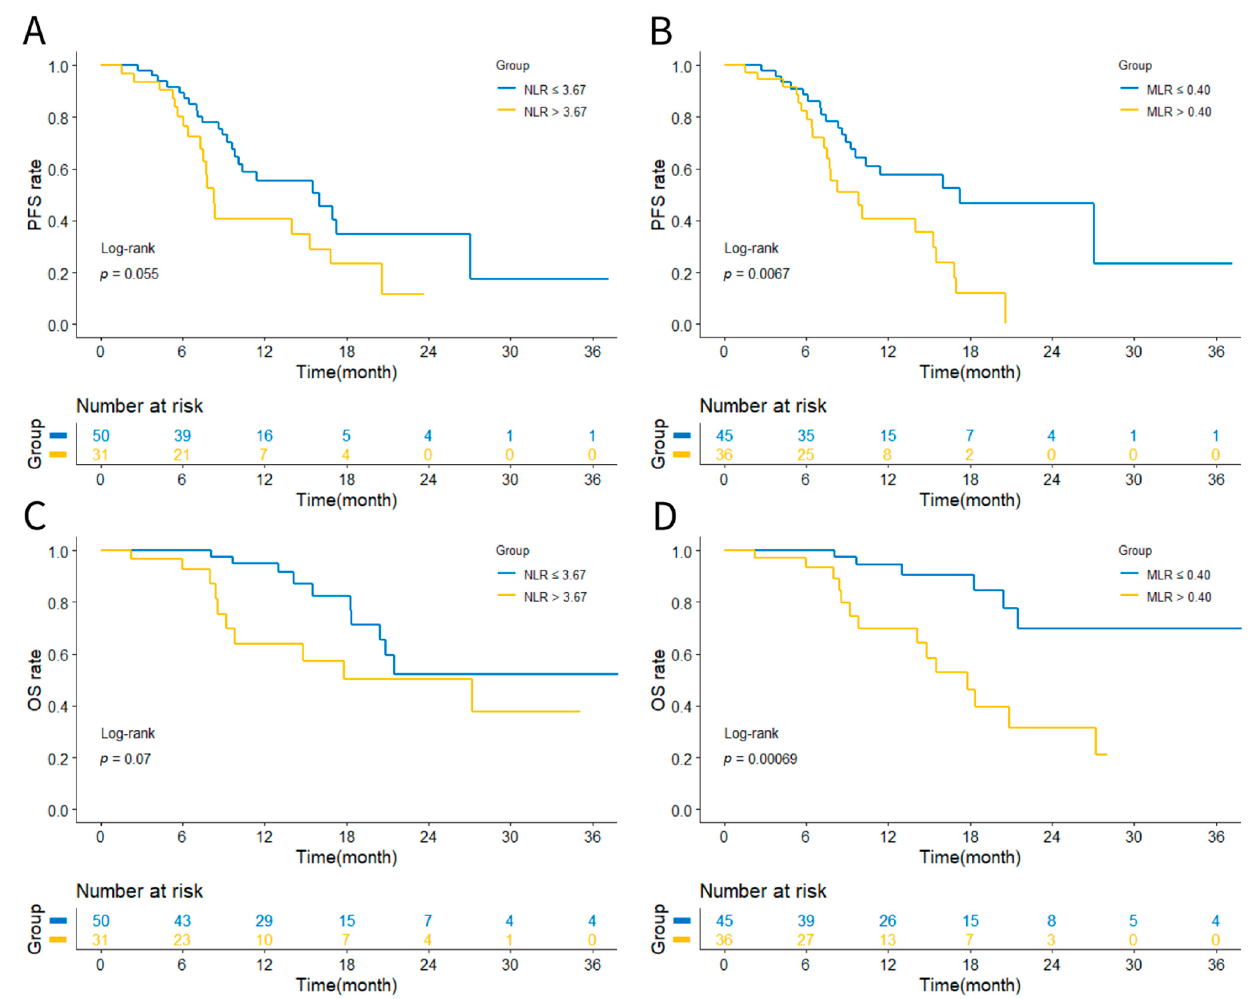
Figure 2. Kaplan–Meier survival curves of NLR and MLR. ( A ) PFS curves of NLR. ( B ) PFS curves of MLR. ( C ) OS curves of NLR. ( D ) OS curves of MLR. Abbreviations: NLR, neutrophil-to-lymphocyte ratio; MLR, monocyte-to-lymphocyte ratio; PFS, progression free survival; OS overall survival.